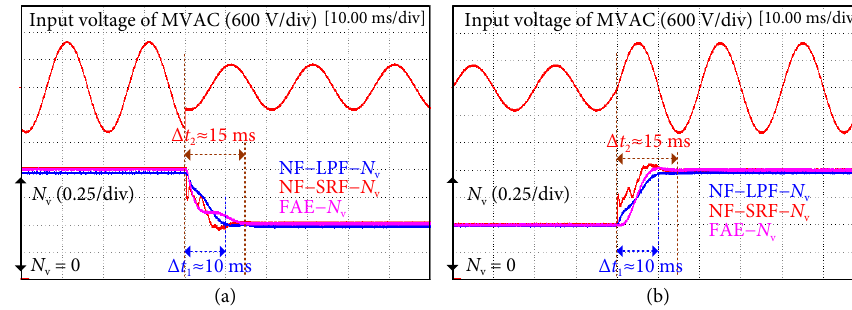
Fig. 13 Experimental results with a voltage sag-depth of 0.5. (a) Sag transition. (b) Recovery transition.